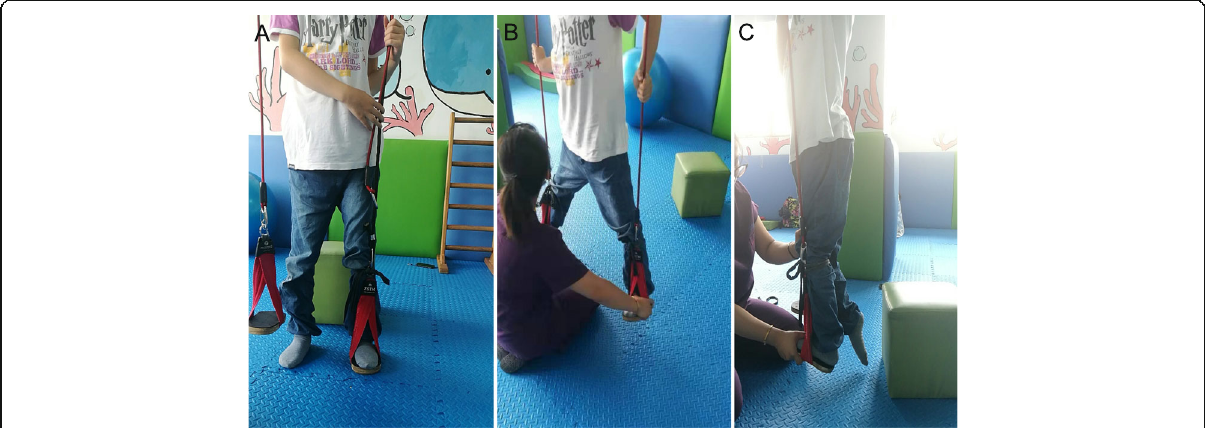
Fig. 3 Photos of physical therapy of the patient. a Unilateral lower limb resistance standing. b Autonomous outreach training on slings. c Autonomous Achilles tendon stretching training